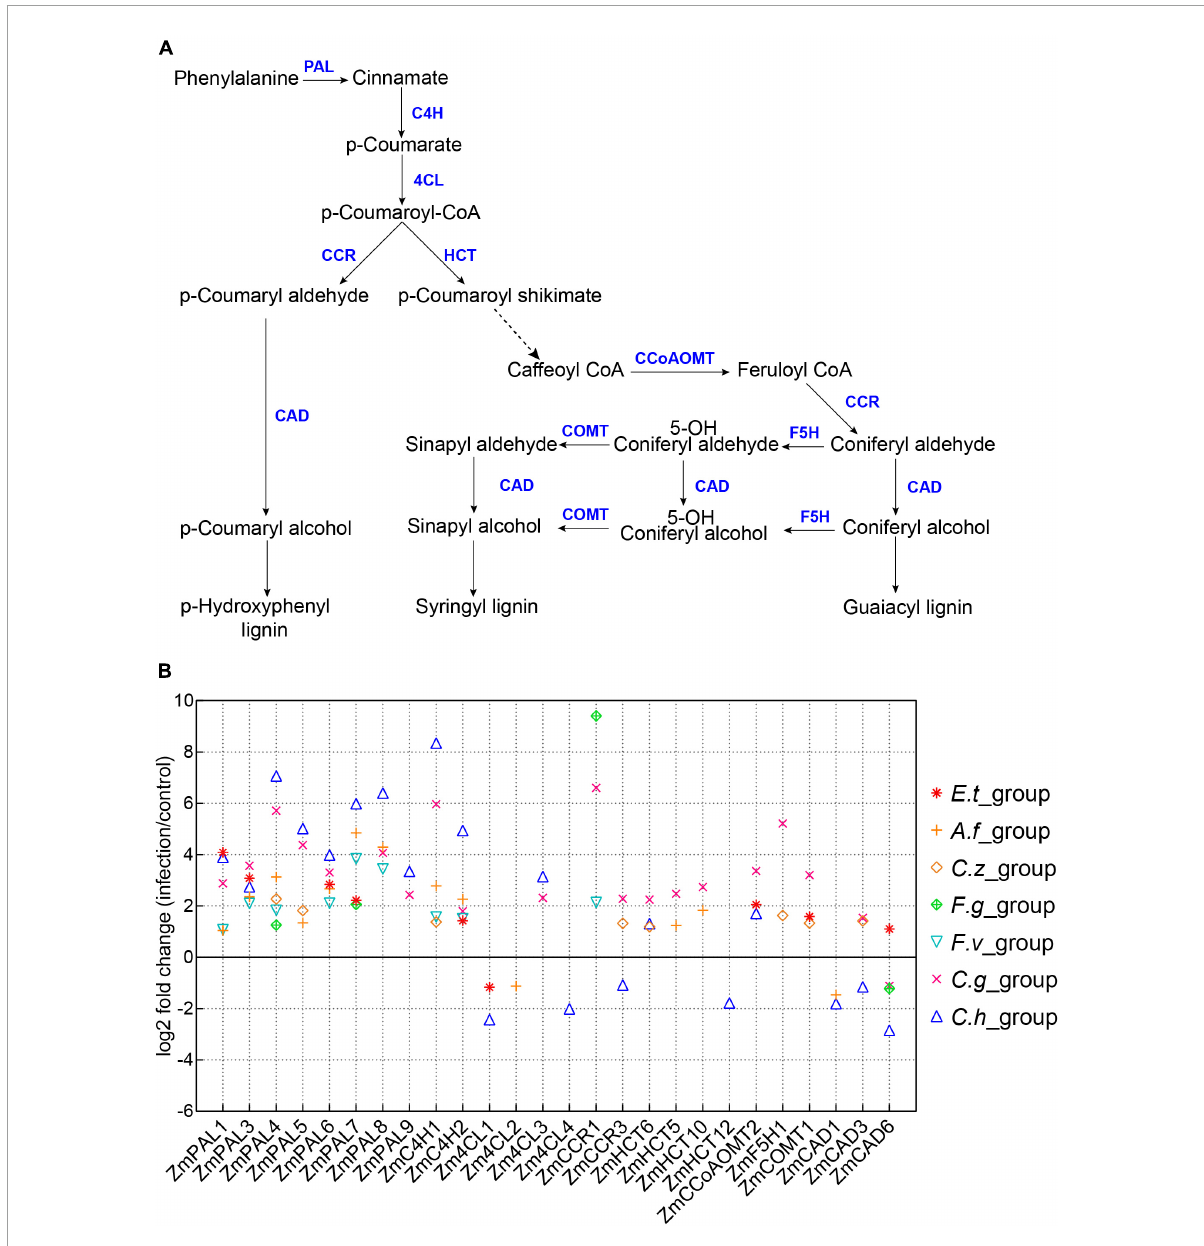
FIGURE5 Expression patterns of lignin biosynthesis related genes. (A) A model of lignin biosynthesis. PAL, phenylalanine ammonia lyase; C4H, cinnamate 4-hydroxylase; 4CL, 4-coumarate CoA ligase; HCT, hydroxycinnamoyl CoA; CCR, cinnamoyl CoA reductase; CCoAOMT, caffeoyl CoA O-methyltransferase; F5H, ferulate 5-hydroxylase; COMT, caffeic acid O-methyltransferase; CAD, cinnamyl alcohol dehydrogenase. (B) Log2(Fold Change) of maize lignin biosynthesis-related genes, the seven inoculation groups are indicated by different symbols in the